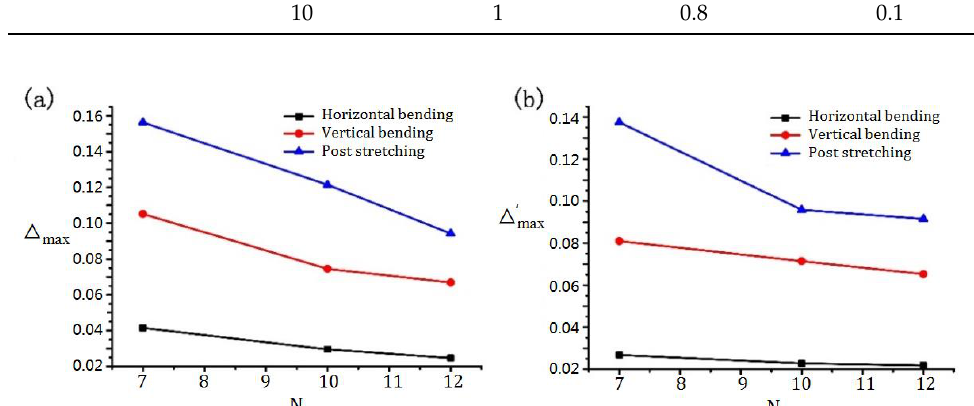
Figure 4. The effect of the number of multi-point dies on thinning. ( a ) Outer web. ( b ) Inner web.